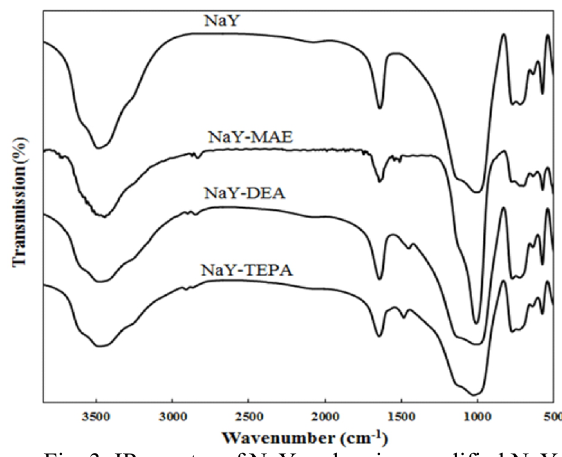
Fig. 3. IR spectra of NaY and amine-modified NaY